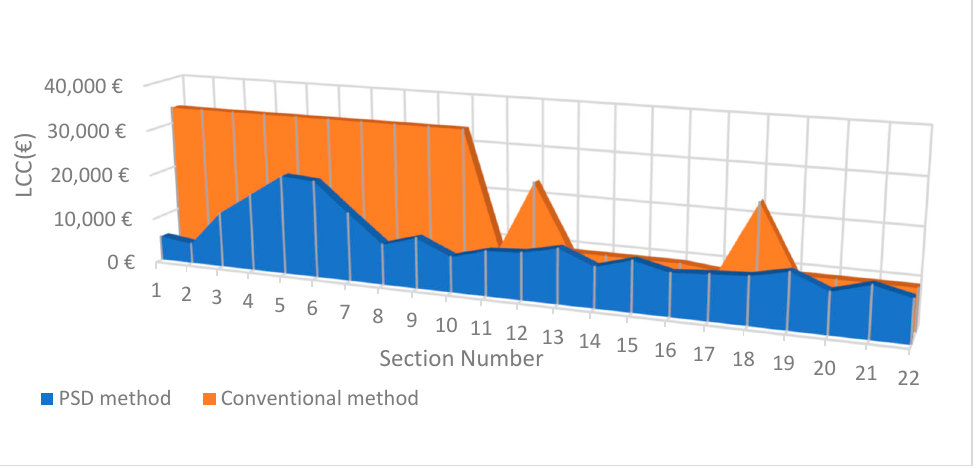
Figure 7. The life-cycle cost assessment for the Arosa bridge until the end of bridge life.